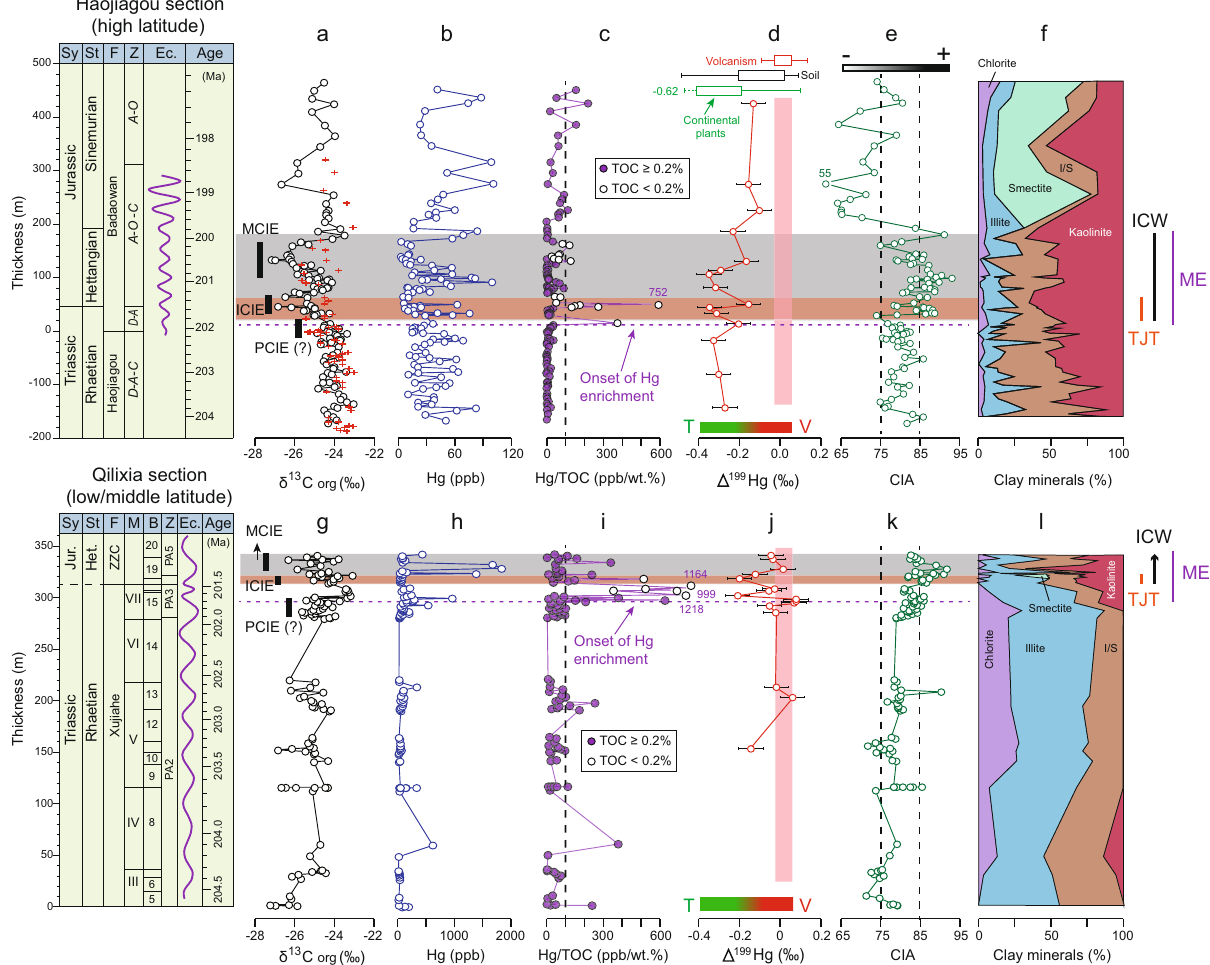
Fig. 2 Pro fi les of Haojiagou (Upper, HJG) and Qilixia (Lower, QLX) sections. ( a , g ) Organic carbon isotope ( δ 13 C org , ‰ ); ( b , h ) Mercury concentrations (Hg, ppb); ( c , i ) Ratios of mercury to total organic carbon (Hg/TOC, ppb/wt.%); ( d , j ) Mass independence fractionation of odd-Hg isotope ( Δ 199 Hg, ‰ ); ( e , k ) Chemical index of alteration (CIA) and ( f , l ) clay minerals. The eccentricity cycle and ages are from Sha et al. 53 and Li et al. 70 for Haojiagou and Qilixia respectively. The red crosses in represent δ 13 C org data from Sha et al. 53 . Open and purple fi lled circles in c and i represent samples with TOC < 0.2 wt.% and ≥ 0.2 wt.%, respectively. ICW Intense chemical weathering interval; TJT Triassic – Jurassic transition; ME mercury-enriched interval. The red and green bar at the base of column d and j represent the volcanic (V) and terrestrial (T) compositions of Δ 199 Hg respectively. The arrow for the ICW represents the uncompleted records in the Early Jurassic for QLX. The horizon bars of the Δ 199 Hg pro fi les represent standard deviation (2 σ )